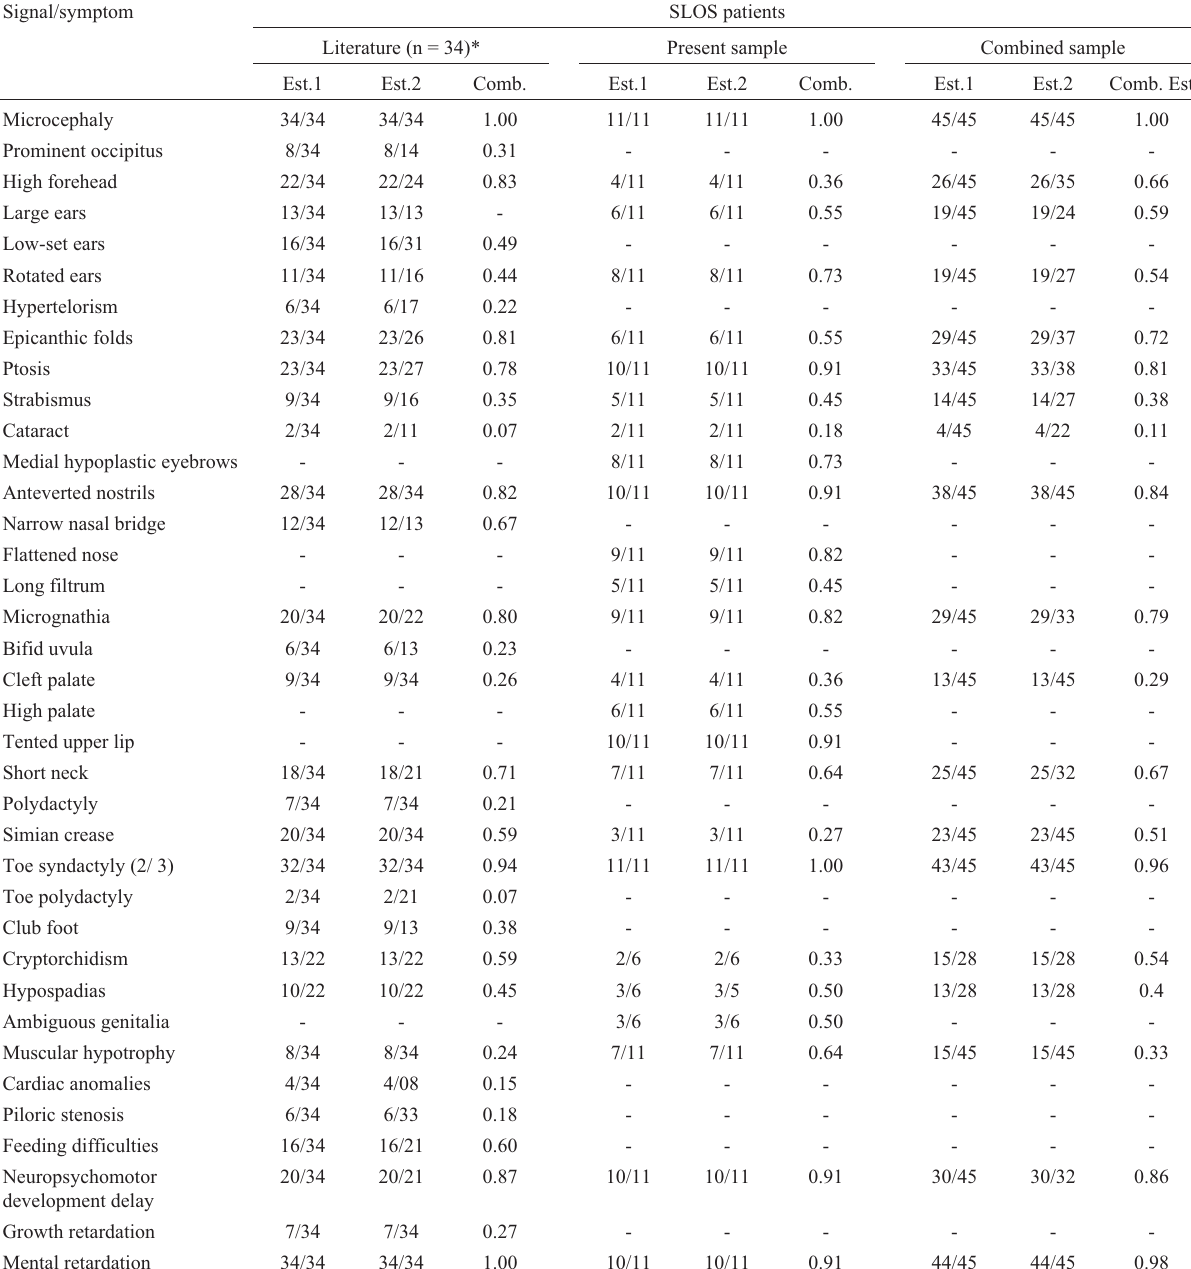
Table 1 - Estimated frequencies of the signs/symptoms found in SLOS patients (literature and present study).